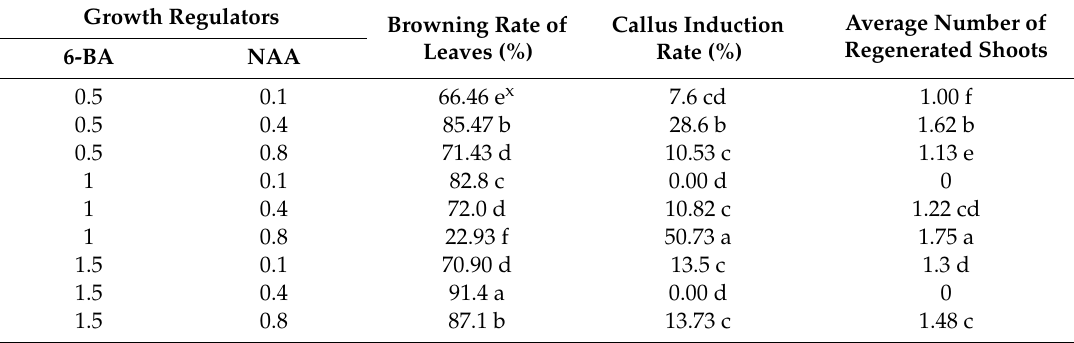
Table 4. E ff ects of 6-BA and NAA hormones combinations on browning rate of leaves, callus induction rate, and the average number of regenerated shoots of